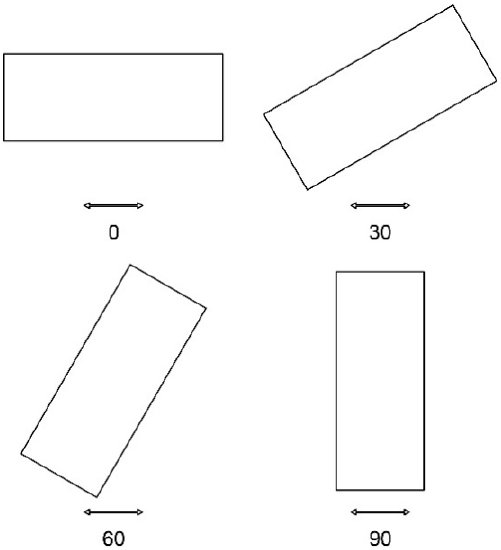
Figure 2. Plan view of excitation direction in comparison with tank orientations.